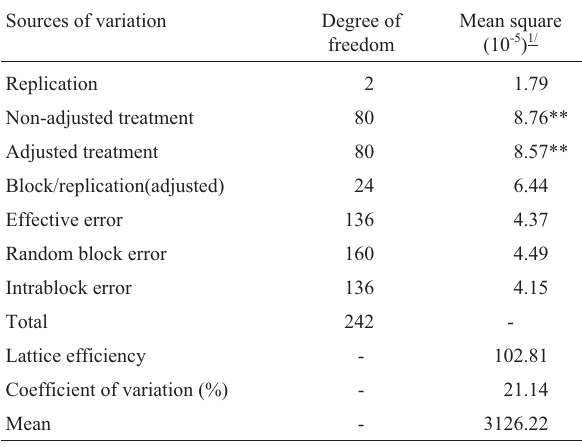
TableII - Varianceanalysisofgrainyield(kg/ha)ofparents,controlsand F 2 populations.